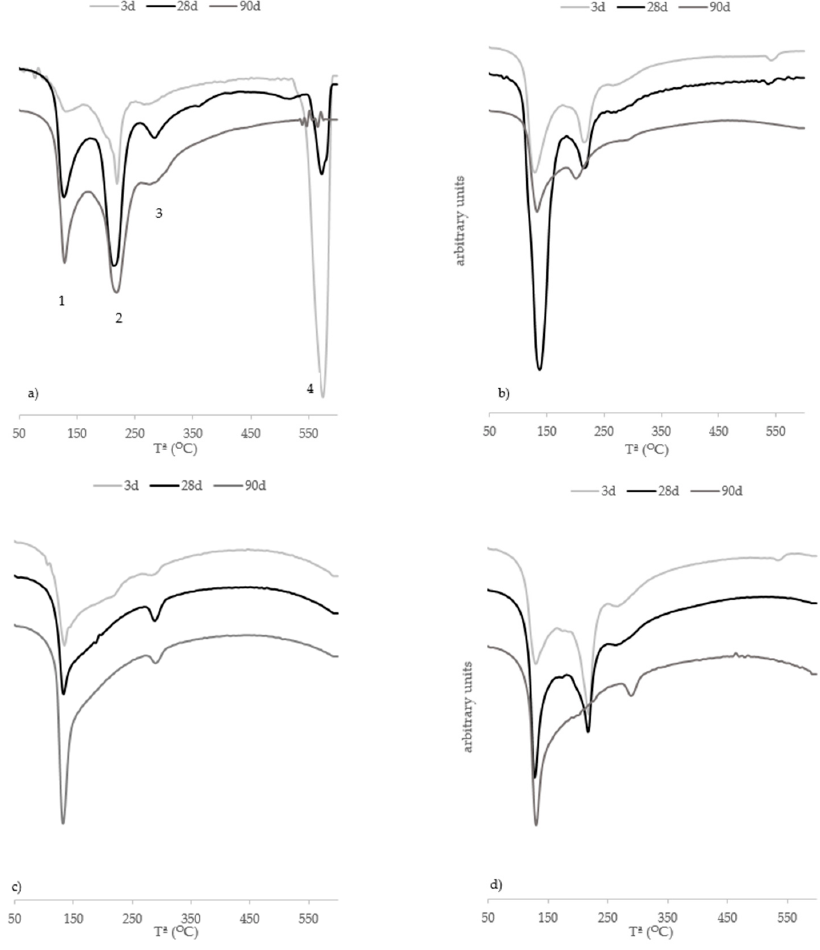
Figure 10 Figure 10. DTG curves of pastes at 3, 28 and 90 curing days: ( a ) T-FCC; ( b ) H-FCC/C; ( c ) H-FCC/RHA; ( d )